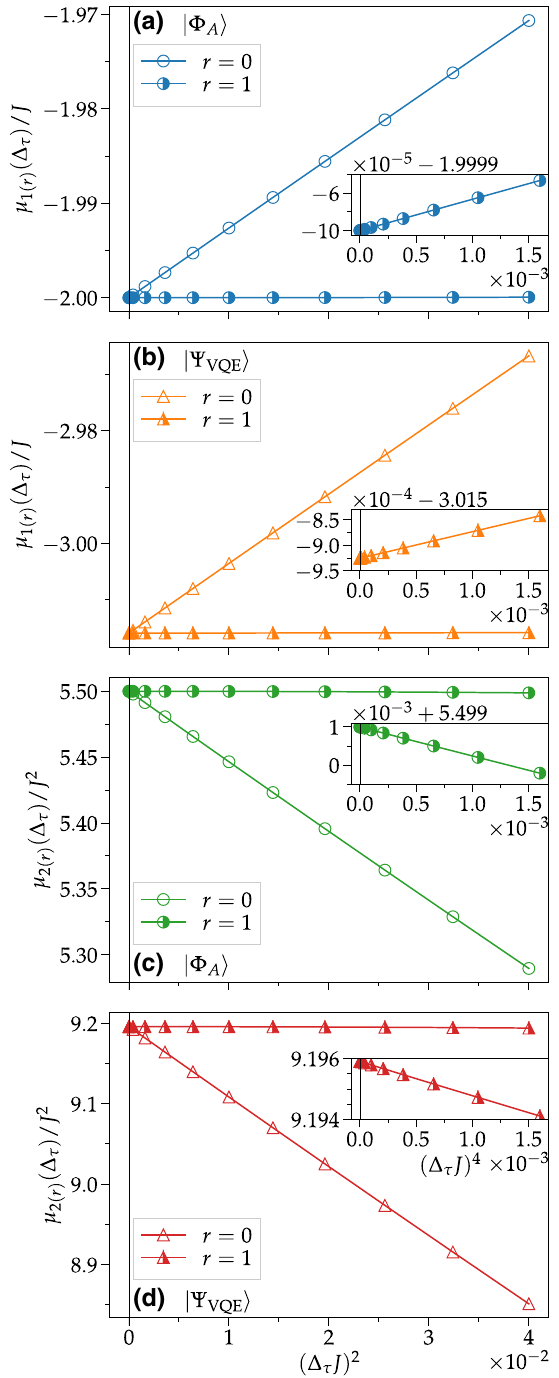
FIG. 21. (a),(b) The first moment μ 1 and (c),(d) the second moment μ 2 as a function of (cid:3) 2 τ evaluated from Eqs. (E25) and (E26), respectively, by numerical simulations for the spin- 1 / 2 Heisenberg model on an N = 16 qubit ring. For a quantum state | (cid:6) (cid:3) , we choose (a),(c) the singlet-pair product state | (cid:17) A (cid:3) in Eq. (80) and (b),(d) the VQE state | (cid:6) VQE (cid:3) in Eq. (88). The results obtained by the first-order Richardson extrapolation ( r = 1) are also plotted. The insets show the same results for the first- order Richardson extrapolation but plotted against (cid:3) 4 τ . The exact values are indicated at (cid:3) τ = 0 with the filled